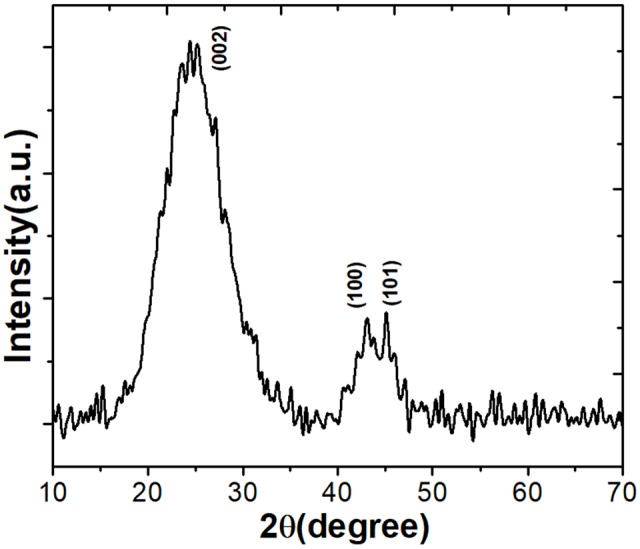
The X-ray diffraction (XRD) pattern of the prepared activated carbon (AC) of J. curcas (ACJC).